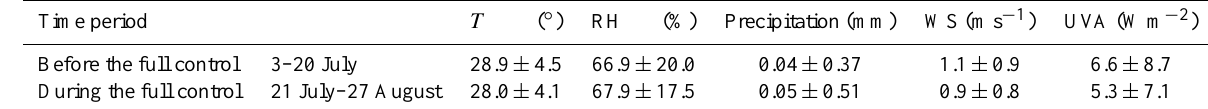
Table 1. Summary of meteorological parameters at the PKU site before and during the full control (average ± 1 σ SD).